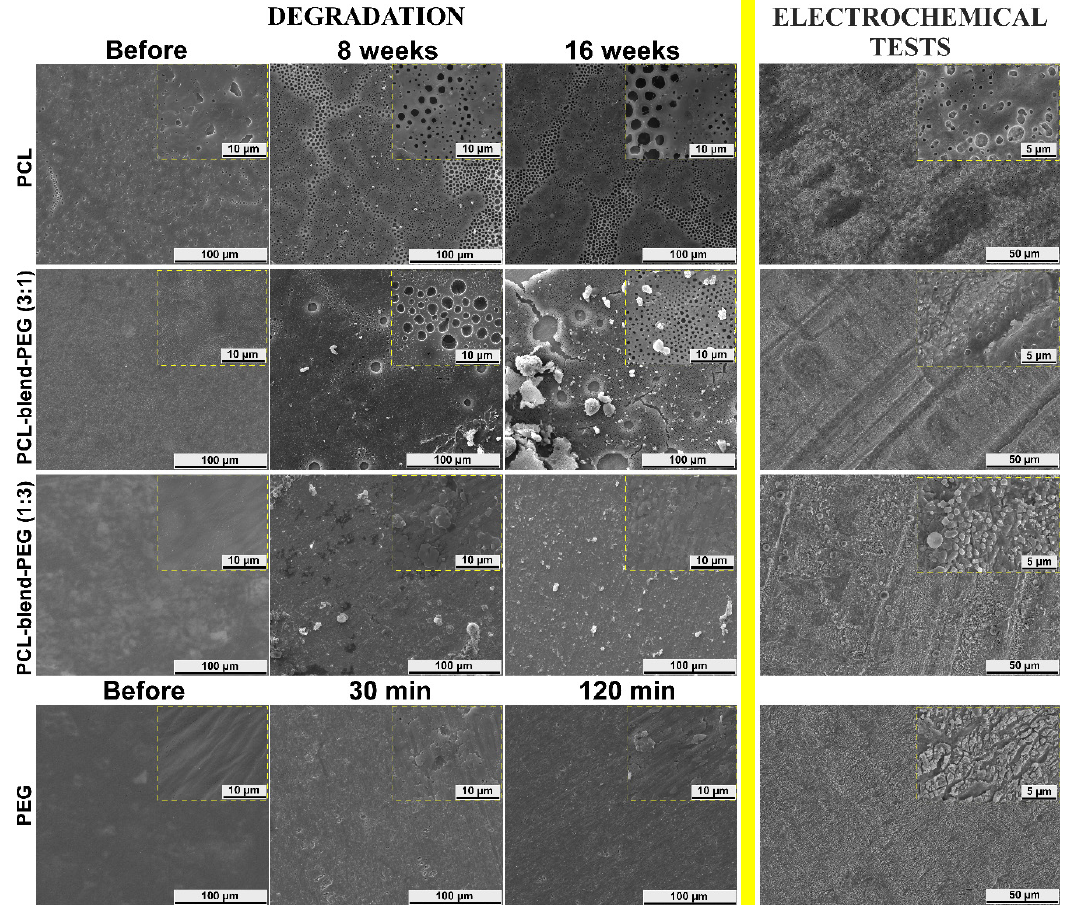
Figure 7. Representative SEM images of simple PCL and PCL-blend-PEG coatings depicted in the first panel, to the left of the yellow line: before degradation (column 1) and after degradation in SBF at 37 °C for 8 weeks (column 2) and for 16 weeks (column 3), respectively. The last row of the panel depicts simple PEG films before degradation (column 1) and after degradation in the SBF at 37 °C for 30 minutes (column 2) and for 120 minutes (column 3), respectively. Coatings’ morphology after electrochemical measurements in SBF is presented in the second panel, to the right of the yellow line.